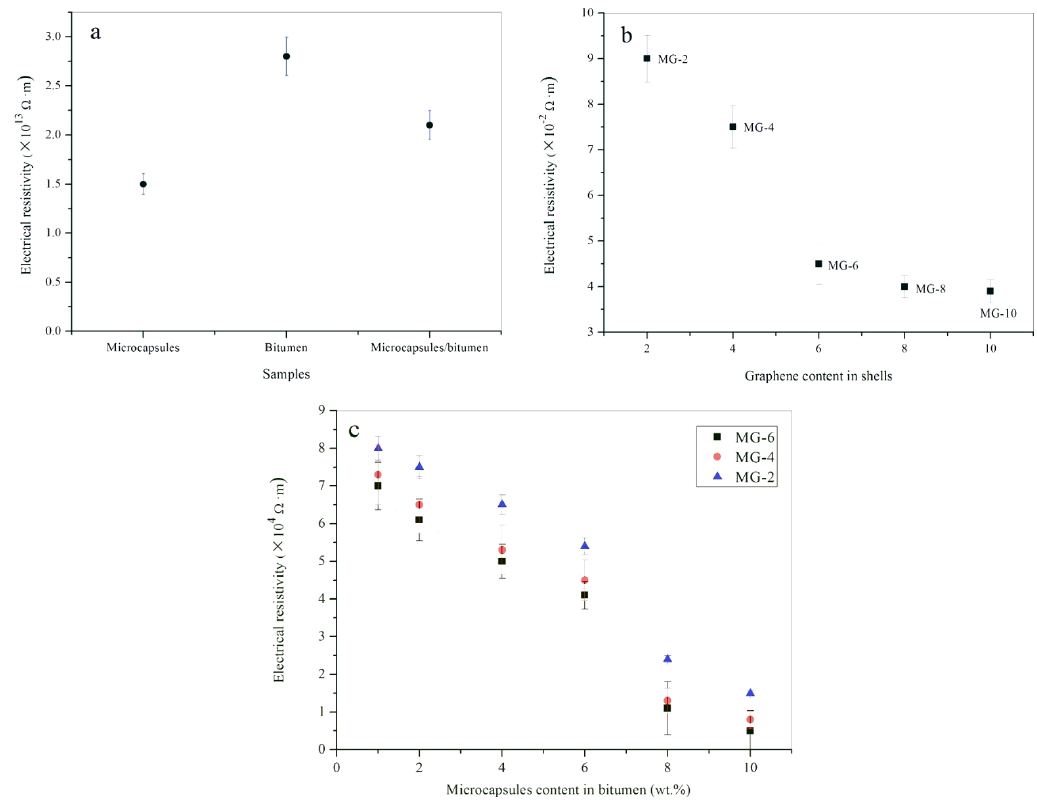
Figure 12. Electrical resistivity of microcapsules and bitumen samples, ( a ) MG-0, pure bitumen, and bitumen with 10 wt % MG-0, ( b ) microcapsule powder samples of MG-2, MG-4, Mg-6, MG-8 and MG-10, and ( c ) bitumen/microcapsule composite samples, MG-2, MG-4 and MG-6 in bitumen with weight content of 1%, 2%, 4%, 6%, 8% and 10%.